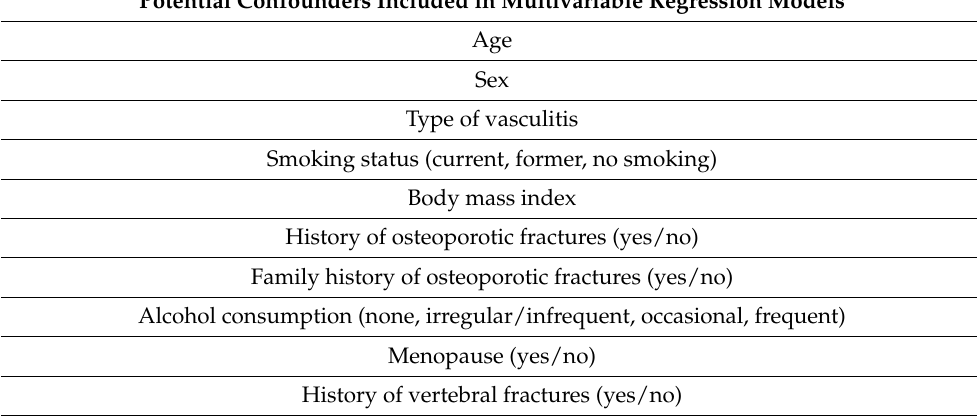
Table 2. Adjustment specifications for multivariable linear regression